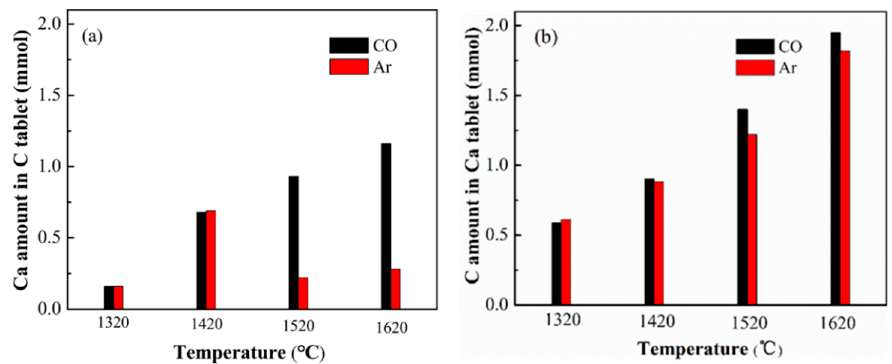
Figure 10. The diffusion amounts of Ca ( a ) and C ( b ) under Ar and CO atmosphere